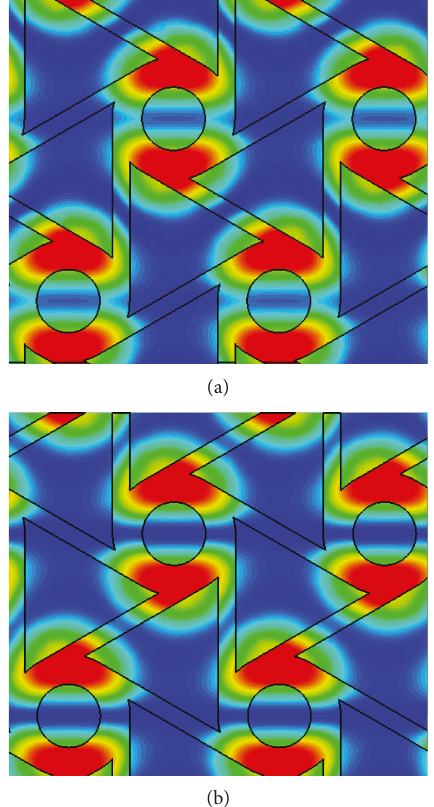
Figure 5: Electric energy density for a vertical polarized plane wave, at a frequency of 9.7GHz: (a) fi rst layer; (b) second layer.